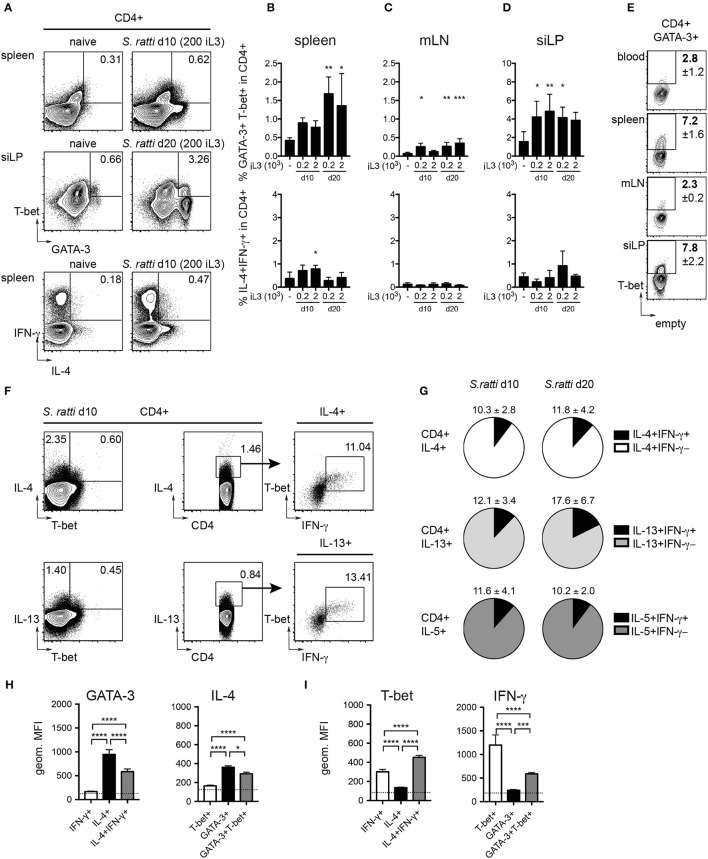
Th2/1 cells with combined Th2 and Th1 features are induced during S. ratti infection. Mice infected with 200 or 2,000 S. ratti stage 3 larvae were screened for Th2/1 cells co-expressing Th2 and Th1 lineage transcription factors and cytokines. (A) Exemplary flow cytometry plots of live CD4+ T cells derived from spleen (top and bottom) and small intestinal lamina propria (middle) of an uninfected control and S. ratti infected mouse at the depicted days post infection. Numbers indicate frequencies of GATA-3+T-bet+ and IL-4+IFN-γ+ cells, respectively. (B–D) Frequencies of GATA-3+T-bet+ cells (top) and IL-4+IFN-γ+ cells (bottom) within live CD4+ T cells isolated from spleen (B), mLN (C) and siLP (D) as detected after 4h of PMA/ionomycin stimulation. Significance was tested comparing infected and naïve controls. (E) Exemplary plots depicting frequencies of T-bet expressing cells in CD4+GATA-3+ T cells derived from peripheral blood, spleen, mLN and siLP of mice infected for 10 days (200 iL3) stained directly ex vivo. Numbers indicate mean values and SD of 4-5 mice. (F) Concatenated plots depicting IL-4 single and IL-4/T-bet co-expressing cells (top left) and IL-13 single and IL-13/T-bet co-expressing cells (bottom left) in CD4 cells isolated from spleens of 5 mice infected for 10 days with S. ratti (200 iL3). Center and right plots show detection of T-bet+ IFN-γ producing cells in the IL-4 and IL-13 producing populations. (G) Pie charts depict proportions of IFN-γ+ Th2/1 cells (black) within the IL-4 (white), IL-13 (light gray) and IL-5 (dark gray) producing CD4+GATA-3+ T cell derived from spleens of mice infected with S. ratti (200 iL3) for 10 (left) and 20 days (right). Mean and SD of n = 5 mice is shown. (H,I) Geometric mean fluorescence intensity (MFI) of GATA-3 and IL-4 (H) and T-bet and IFN-γ signals (I) of the depicted CD4+ subpopulations derived from mice infected with S. ratti (200 iL3) for 10 days. The MFI of IL-4−IFN-γ− and GATA-3−T-bet− cells is depicted by a dotted line. Mean and SD of n = 5 mice. Data originate from one out of two experiments with similar results. *p < 0.05, **p < 0.01, ***p < 0.005, ****p < 0.001.